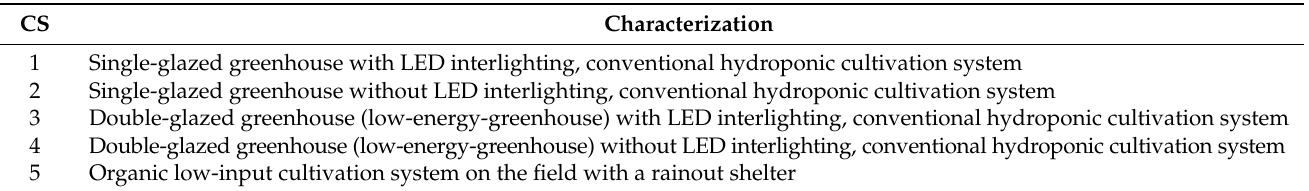
Table 2. Characterization of the five cultivation systems (CS).